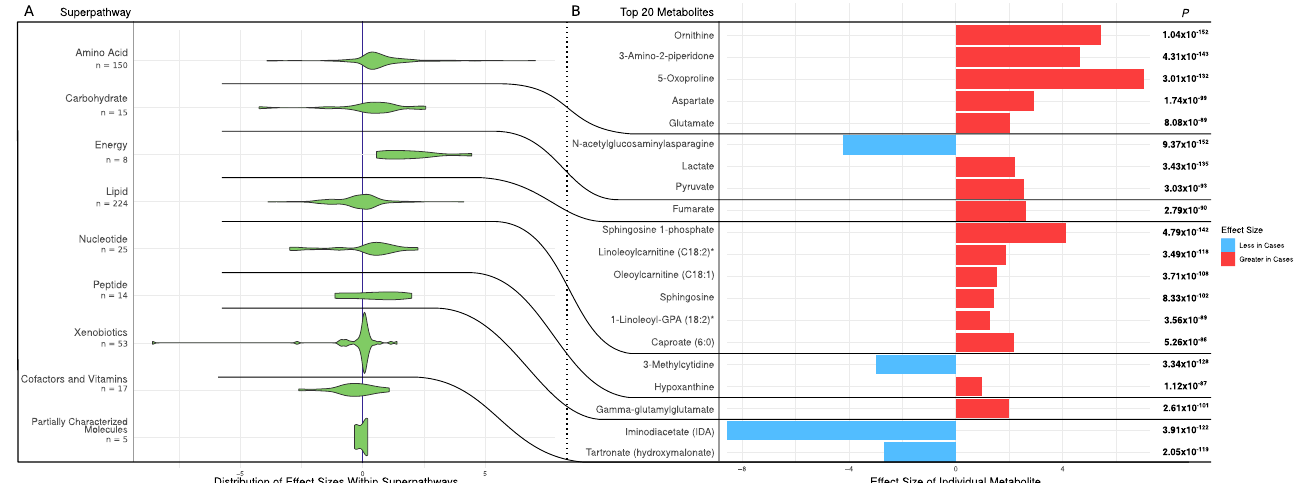
Figure 1. Metabolic differences between CHD patients and controls. ( A ) Distribution of effect sizes of metabolites grouped by super pathways. ( B ) Effect sizes of top 20 significantly different metabolites in cases and controls. p and effect size of the metabolites were calculated using a logistic regression adjusting for age, sex, and BMI. Table 1. The 45 most significant enriched pathways with FDR corrected p < 10 − 300